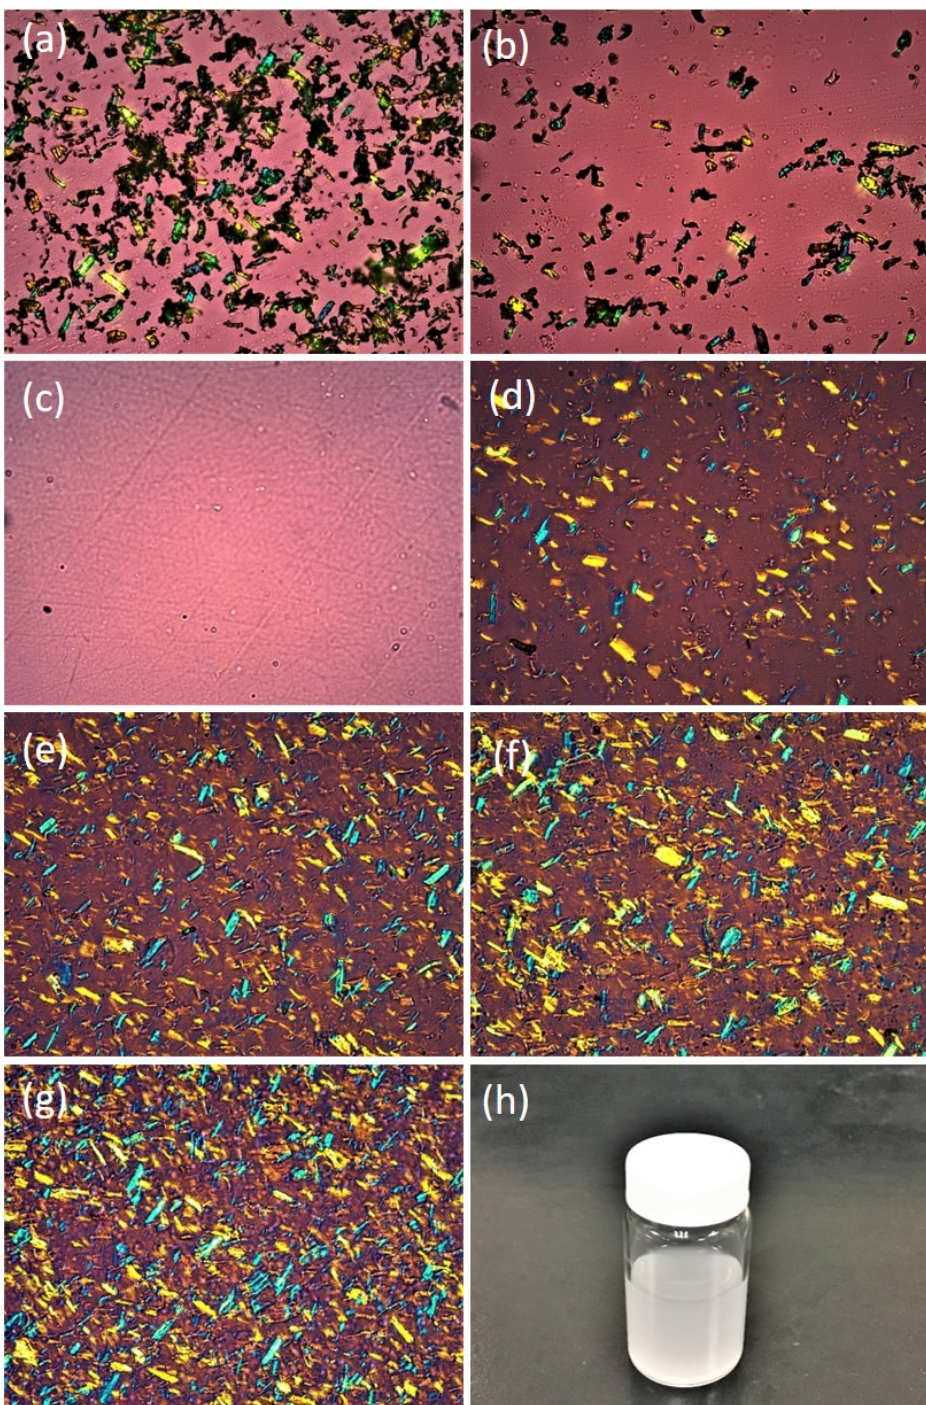
Figure 5. Optical microscope (OM) images of ( a ) CMC in powder form, ( b ) CNC in powder form, ( c ) CS0 film, ( d ) CS2 film, ( e ) CS4 film, ( f ) CS6 film, ( g ) CS8 film, and ( h ) digital image of water dispersed